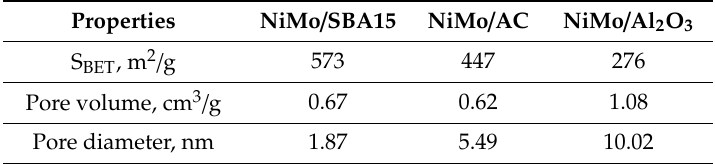
Figure 2. The pore size distribution of the prepared NiMo catalysts: ( i ) NiMo / SBA15 catslyst, ( ii ) NiMo / AC catalyst, ( iii ) NiMo / Al 2 O 3 catalyst. Table 1. Textural parameters of the prepared NiMo catalysts.